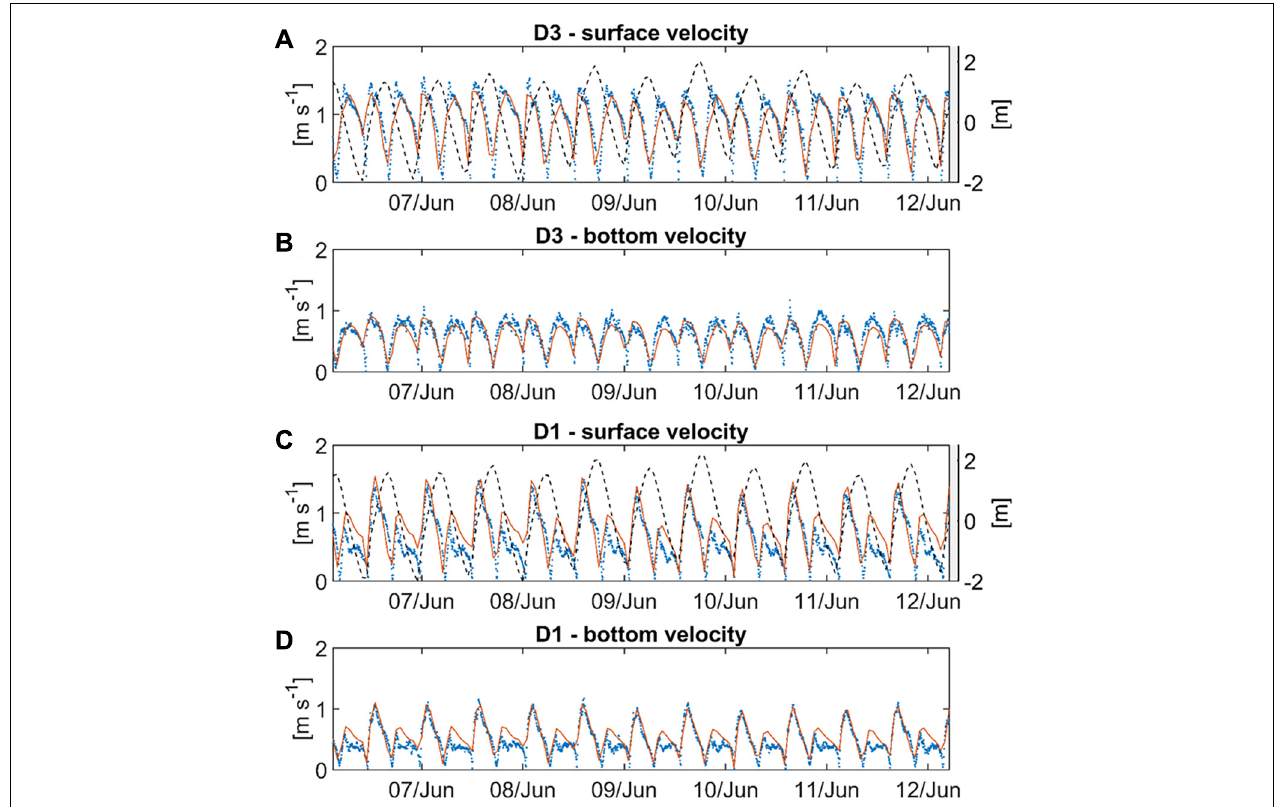
FIGURE 3 | Comparison of the simulated (red solid lines) against the observed (blue dots) (A,C ) surface velocity magnitude and (B,D) bottom velocity magnitude at the measurement stations (A,B) D3 and (C,D) D1 during the period from 6 June to 12 June 2012. The dashed line in (A,C) shows the local water